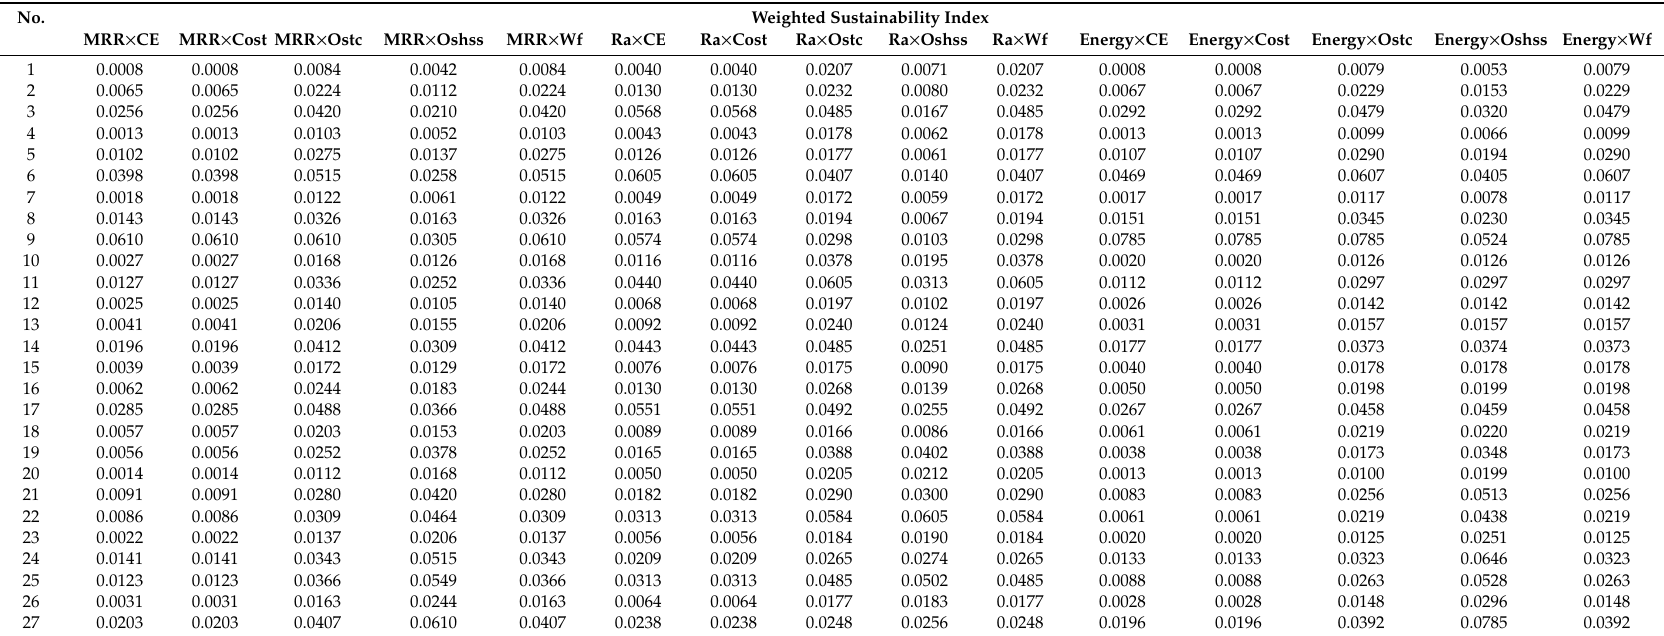
Table A3. OPAI Step 3: Calculation of the weighted sustainability